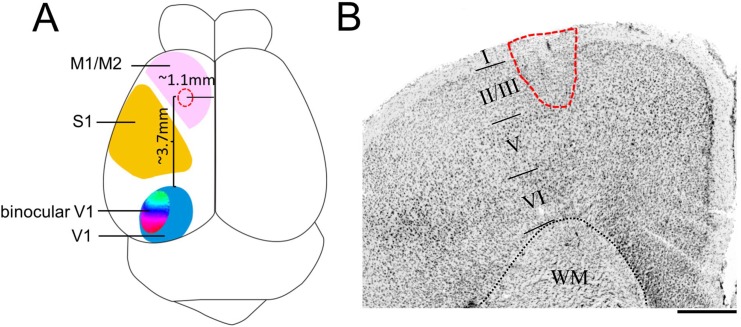
Localization and size of the cortical stroke.(A) Scheme of the average lesion location (red dotted circle/line) and size in the left motor cortex (M2) in respect to the primary visual cortex (V1) of a mouse brain. (B) Nissl-stained frontal section through a representative lesion, WM-white matter. Scale bar: 500μm.